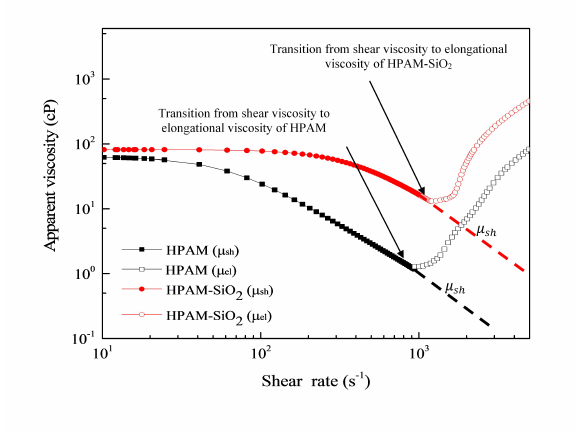
Fig. 11. Apparent viscosity of HPAM and HPAM-SiO 2 NPs in porous media at 60,000ppm